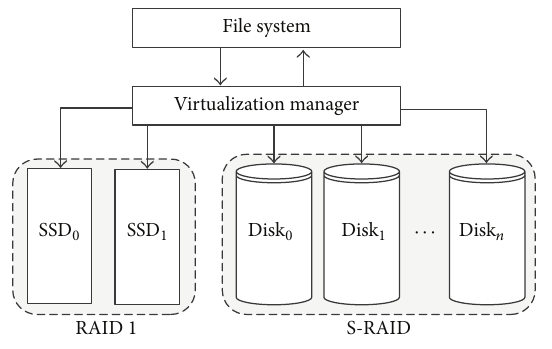
Figure 1: Configuration of Hybrid